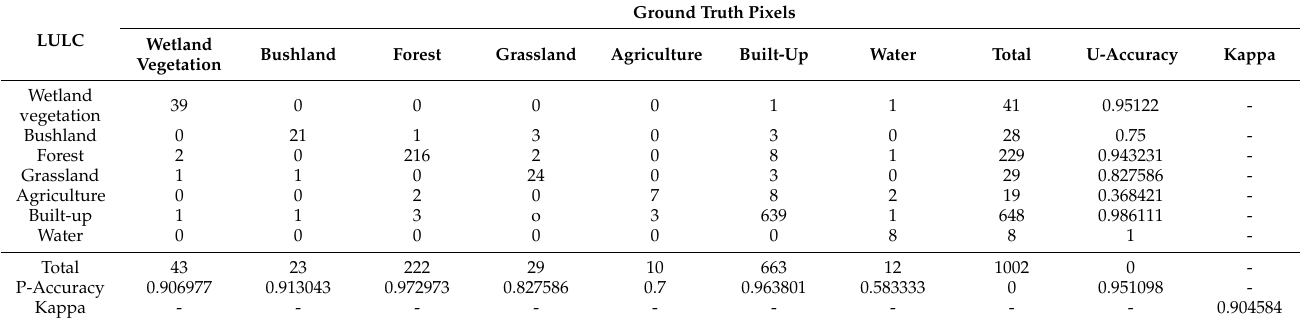
Table 4. Accuracy assessment results of LULC classification for image of 2010.